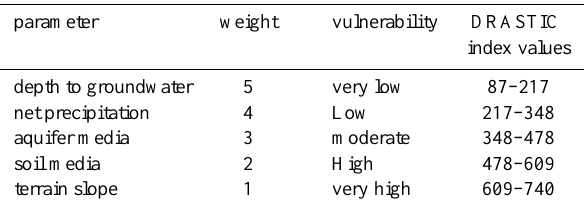
Table 6. DRASTIC index